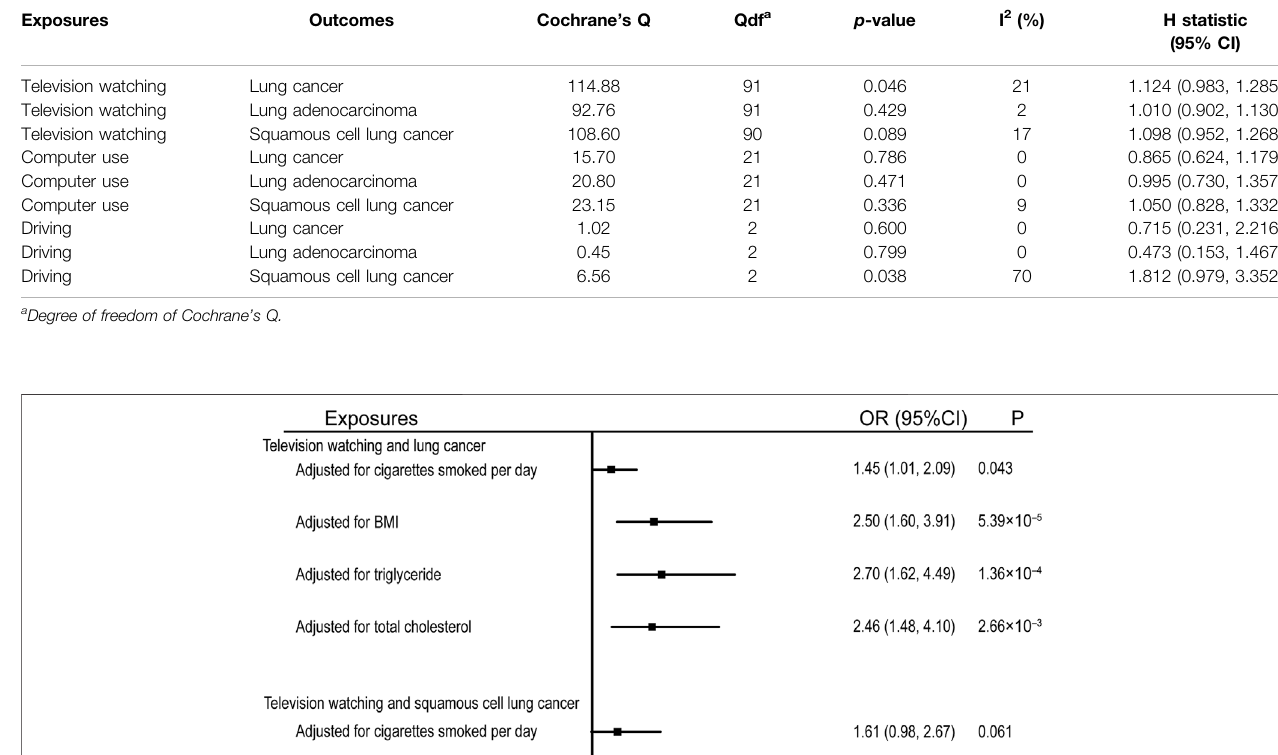
( Figure 1 ). Leave-one-out analysis showed that the associations of television watching with the outcomes were not driven by any single SNP ( Supplementary Figures S3, S15, S27 ). The associations of individual SNPs with exposures and outcomes